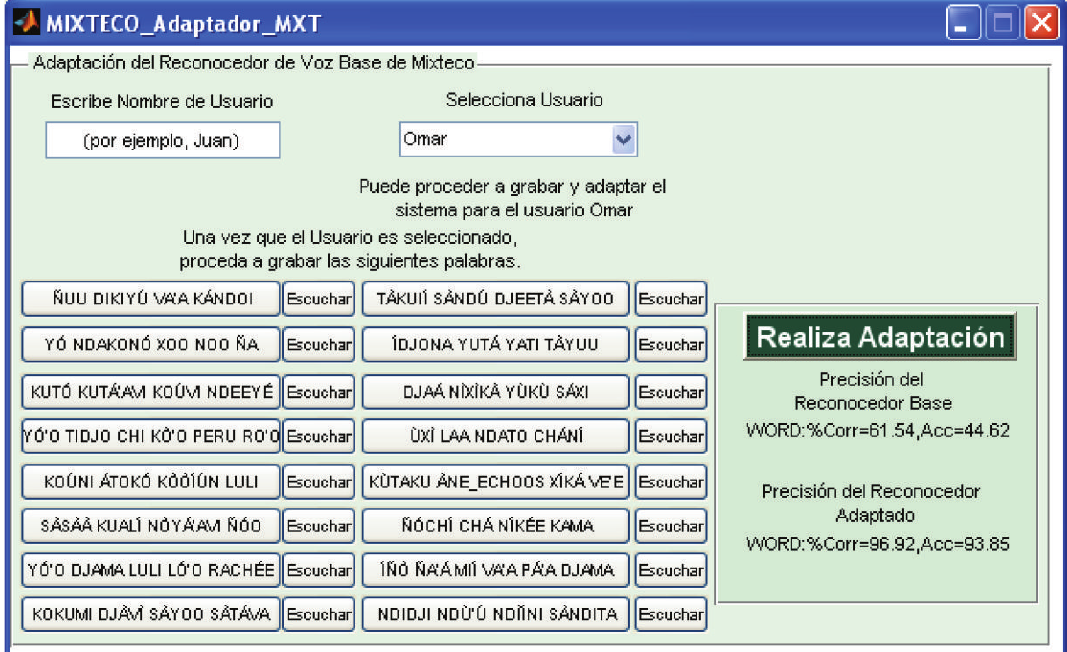
Figure 14: Speaker adaptation module for the baseline Mixtec ASR system.